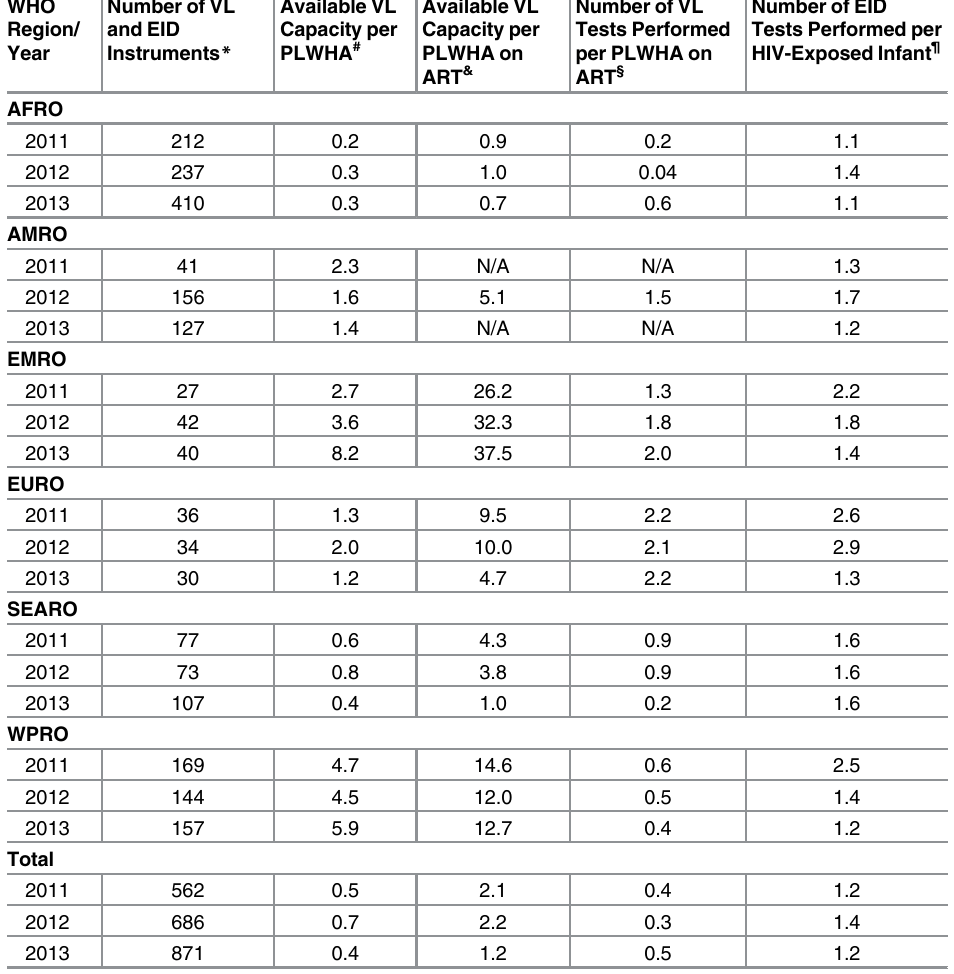
Table 3. Number of VL and EID instruments and available and utilized VL capacity across all reporting countries, disaggregated by WHO